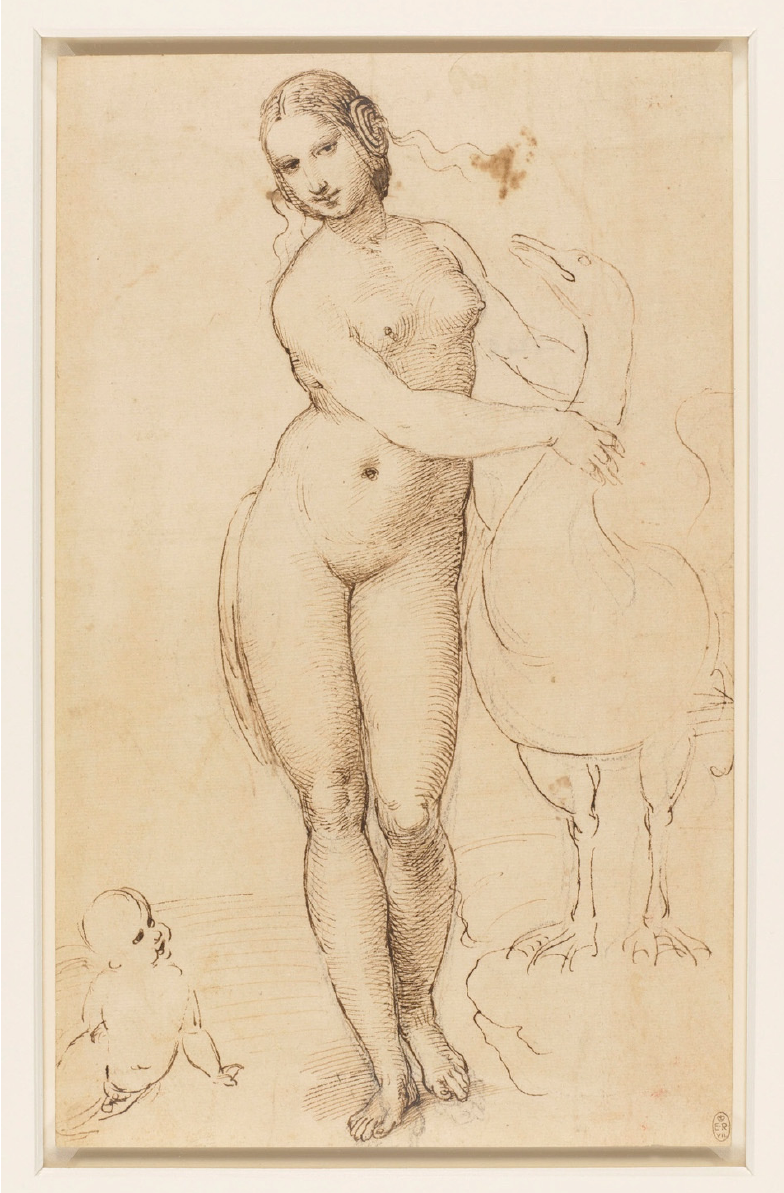
Figure 1. Raphael, Leda and the Swan , ca. 1507, pen and ink over black chalk underdrawing, 210 × 192 mm, RCIN 912759, Royal Collection, Windsor Castle. Royal Collection Trust/© Her Majesty Queen Elizabeth II 2021. Used with permission.